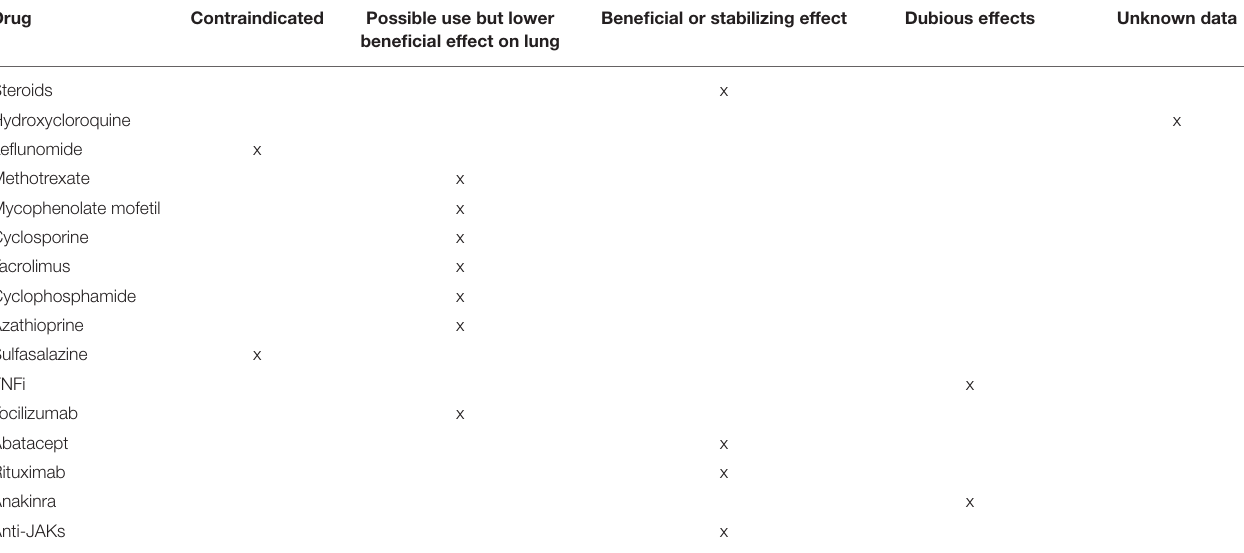
TABLE 3 | Conventional synthetic, biological and targeted synthetic disease-modifying antirheumatic drugs for